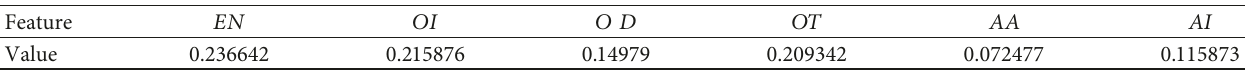
Table 8: Weights of complexity